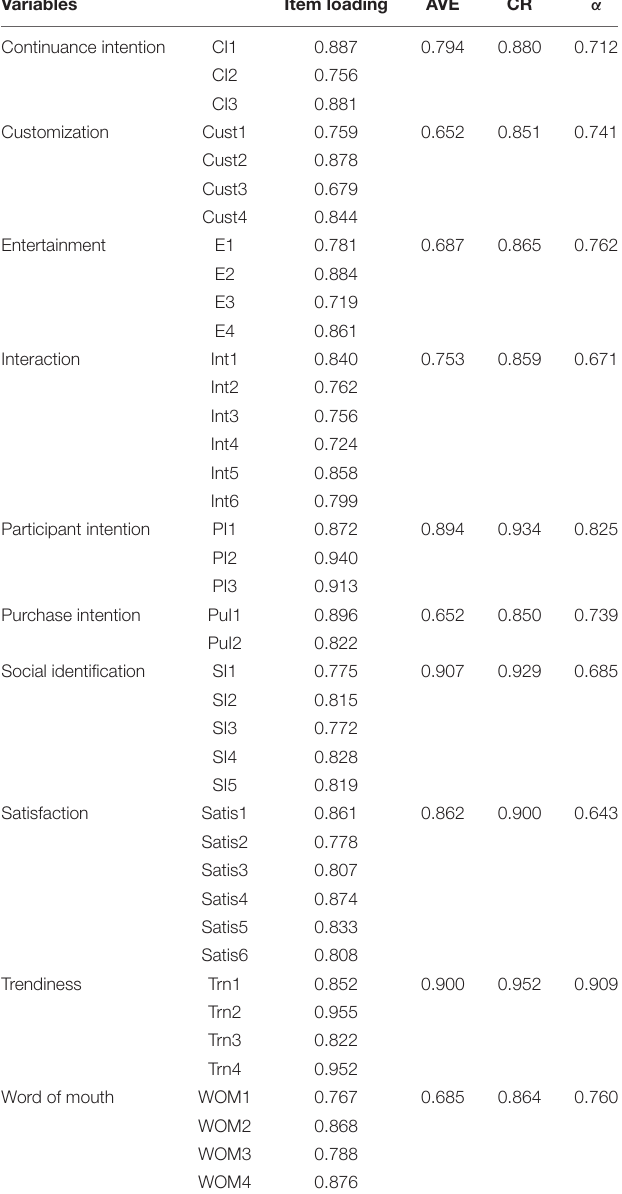
TABLE 1 | Inner model